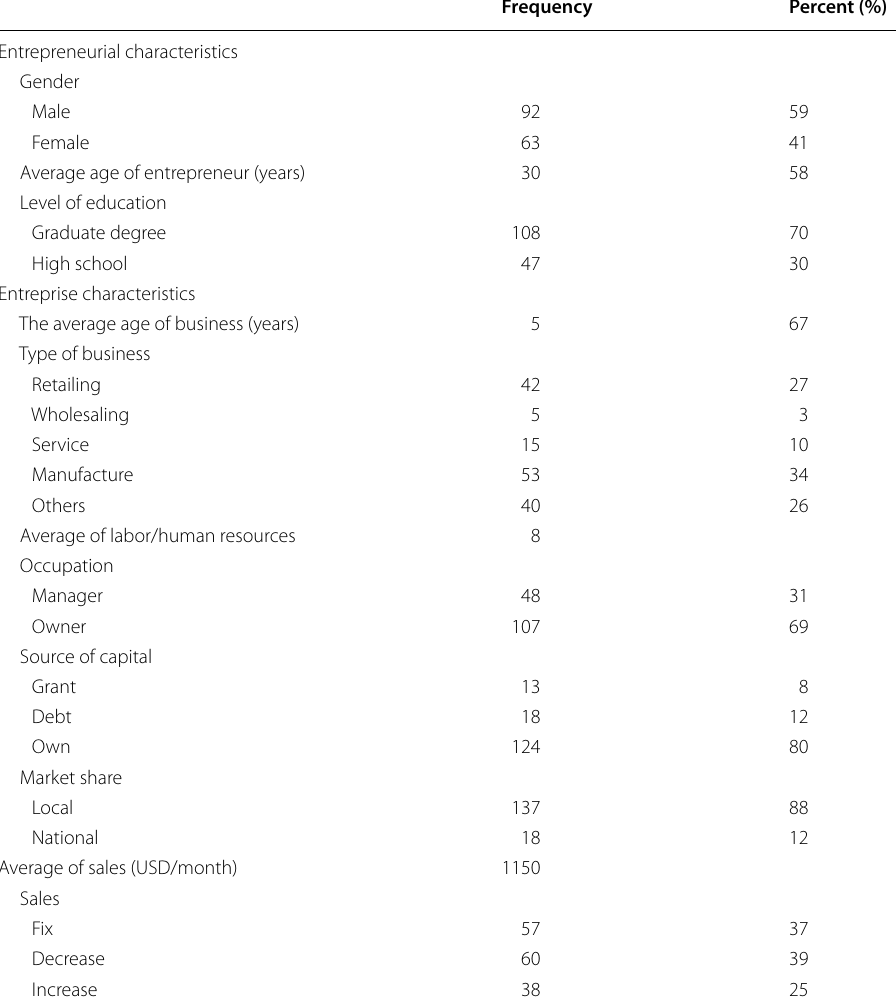
155) = Frequency Percent (%)